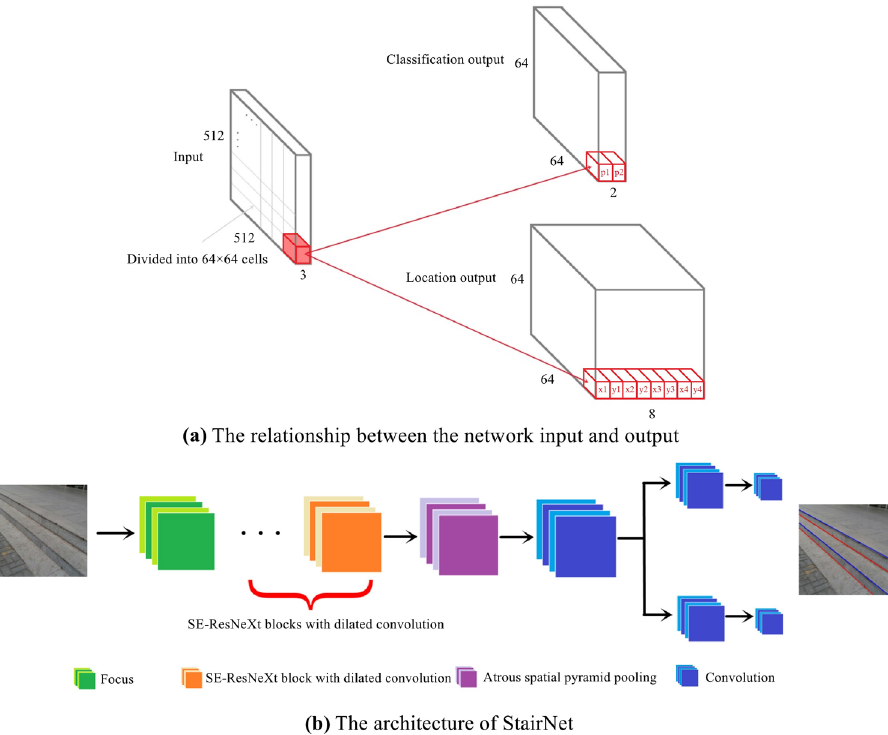
Figure 3. Illustration of the network architecture. ( a ) The relationship between the network input and output. The network takes a 512 × 512 image as input, and the output of the network is divided into two branches. The output target values for the classification branch are stored in a 3D tensor of size 64 × 64 × 2, which is used to judge whether the cell contains convex lines and whether the cell contains concave lines. The output target values for the location branch are stored in a 3D tensor of size 64 × 64 × 8, which is used to predict the locations of two sets of stair lines. ( b ) The architecture of our network. The backbone contains a focus module, several SE-ResNeXt blocks with dilated convolution and an ASPP